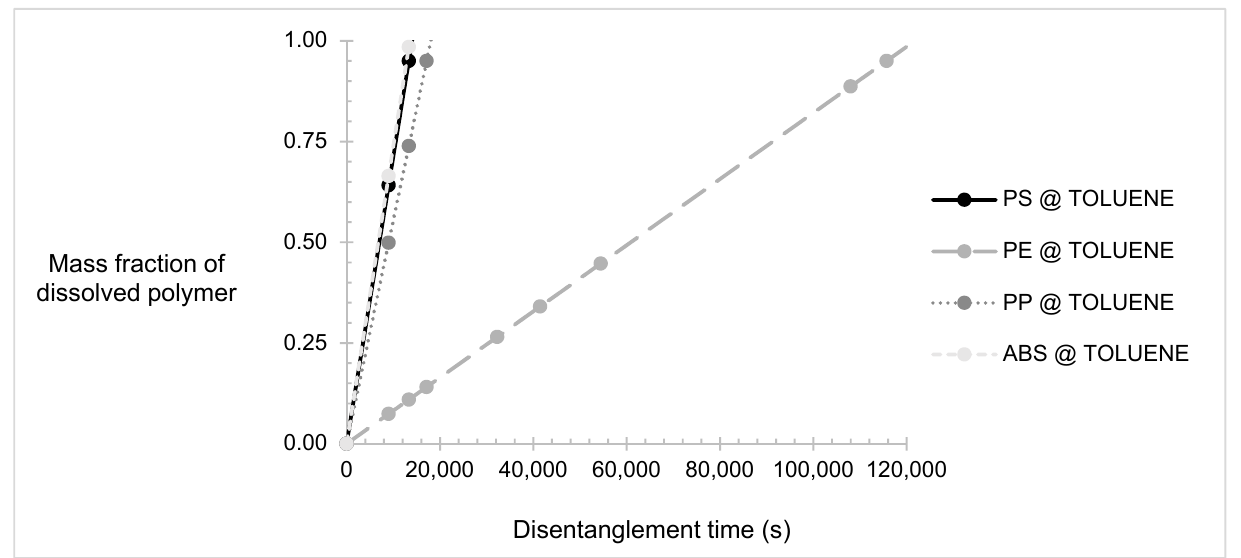
Figure 3. Mass fraction of polymers dissolved in toluene over time. Presenting polypropylene (PP), polystyrene (PS), high-density polyethylene (HDPE), and acrylonitrile–butadiene–rubber (ABS). A quantity of 28.75 m 3 ·d − 1 of toluene was needed to be mixed with 1.2 tonne·d − 1 of